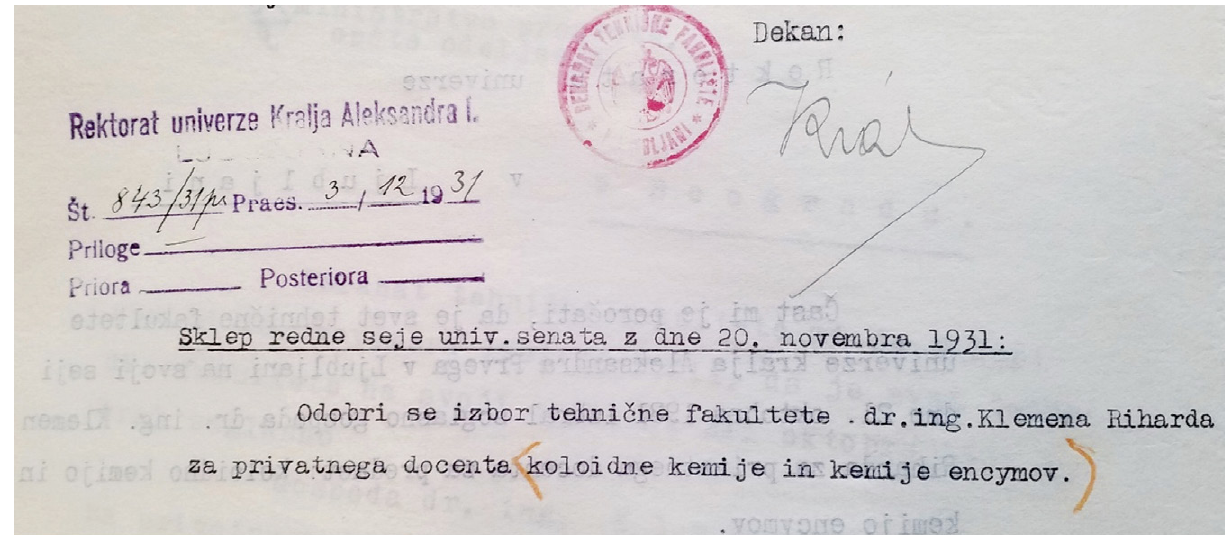
Figure 2: Decision of the university senate dated 20 November 1931 approving election of Richard Klemen as Privat- dozent for colloid chemistry and enzyme chemistry at the Faculty of Technical Sciences. Photographed from civil servant folder preserved at the University of Ljubljana Archives with